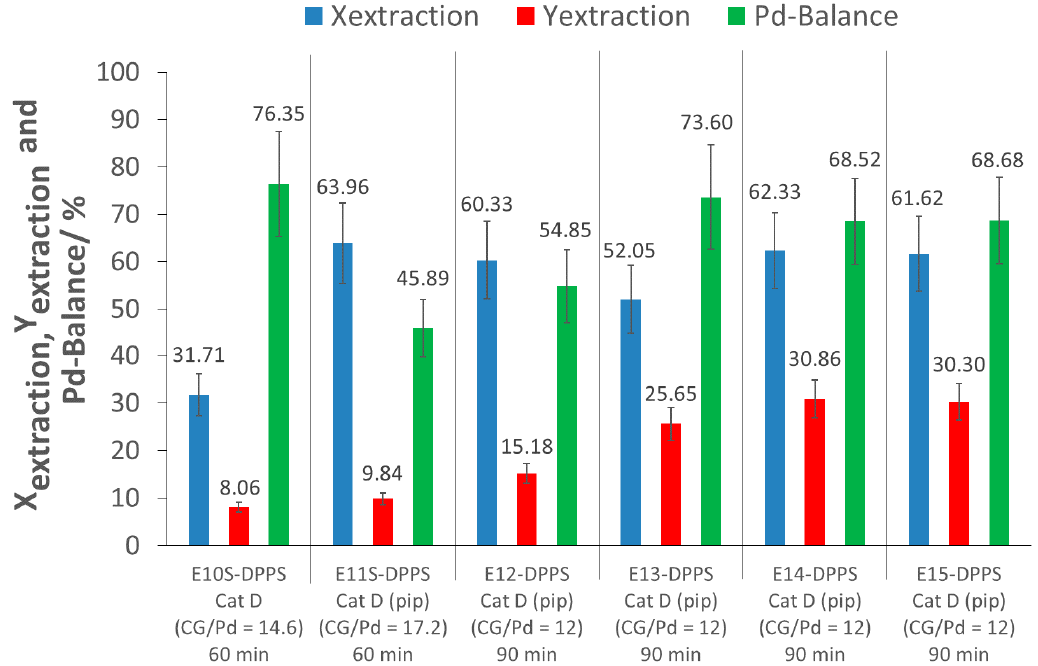
Figure 6. Results of the extractions of Pd with p(FDA- co -DPPS) ((pip): piperidine; CG/Pd: Complexing group/Pd ratio; ExS-DPPS: Screening experiments; Ex-DPPS: Detailed investigation experiments).